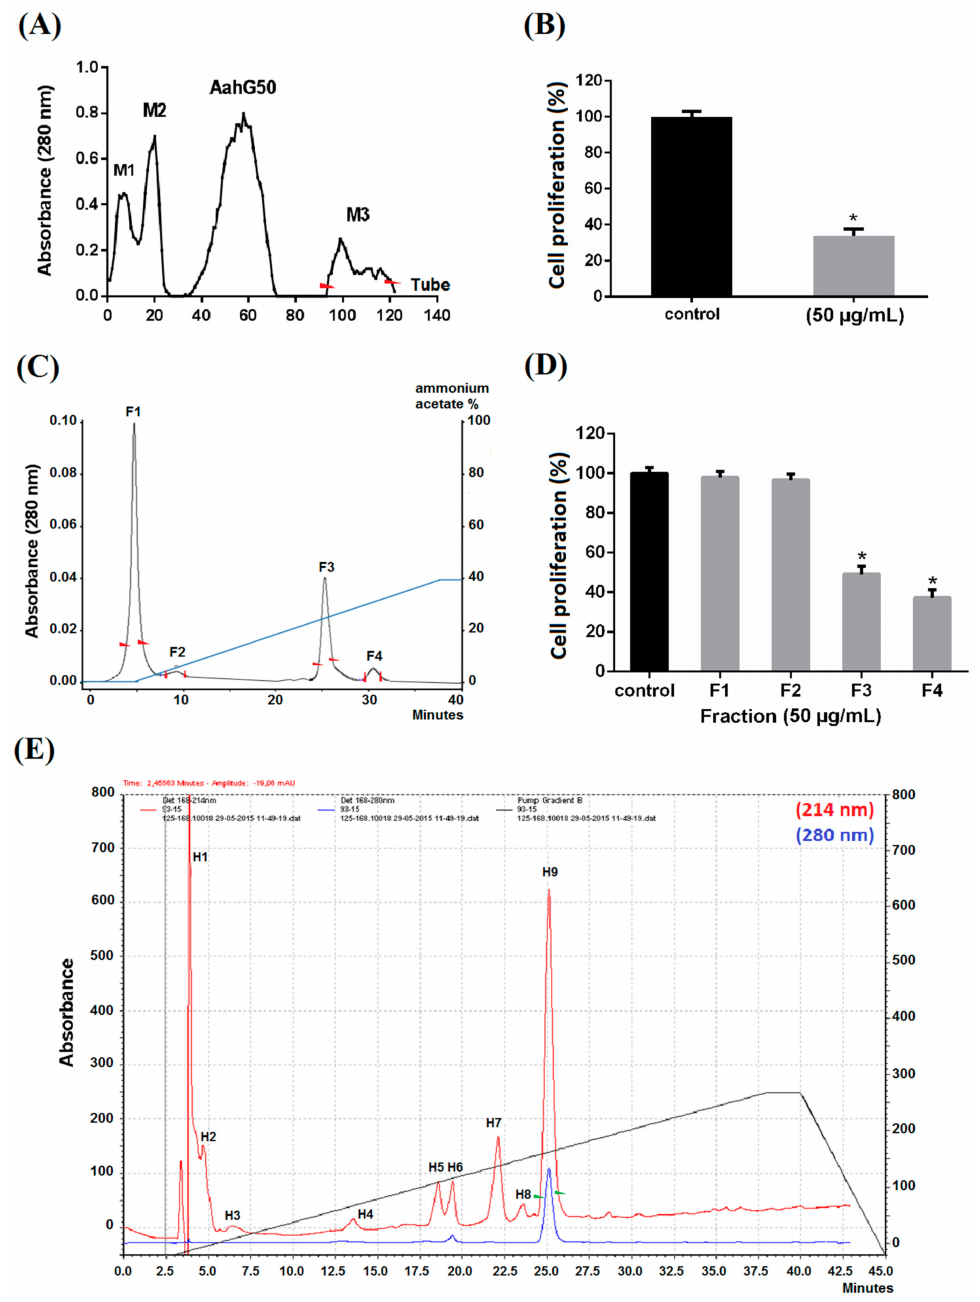
Figure 1. Purification of short bioactive peptides from Aa venom. ( A ) Isolation of the low molecular weight fraction of Aa venom. The crude venom was filtered through Sephadex G-50 gel. Elution was performed with acetic acid (0.1 M) at a flow rate of 0.5 mL/min. The absorbance was measured at 280 nm. Fractions are collected at 2.5 mL/tube. ( B ) Effect of M3 on U87 cell proliferation. The cells were incubated with 50 µ g/mL of M3 for 72 h. Mean, SD. * p < 0.05, significantly different from control. ( C ) Fast liquid chromatography (FPLC) of M3. The M3 was fractionated by cation exchange chromatography using a Resource-S column. Elution was performed with ammonium acetate (0.5 M) at 0.8 mL/min. The absorbance was measured at 280 nm. ( D ) Effect of FPLC fractions on U87 cell proliferation. The cells were incubated with 50 µ g/mL of F1, F2, F3, or F4 for 72 h. Mean, SD. * p < 0.05, significantly different from control. ( E ) The fraction F3 produced by FPLC was purified by High Performance Liquid Chromatography (HPLC) on a C18 column. Elution was carried out with a linear gradient (34 min) from 0% to 30% of 0.1% TFA/acetonitrile. The flow rate was 0.8 mL/min. The absorbance was measured at 214 and 280 nm. Peak range collected was indicated by